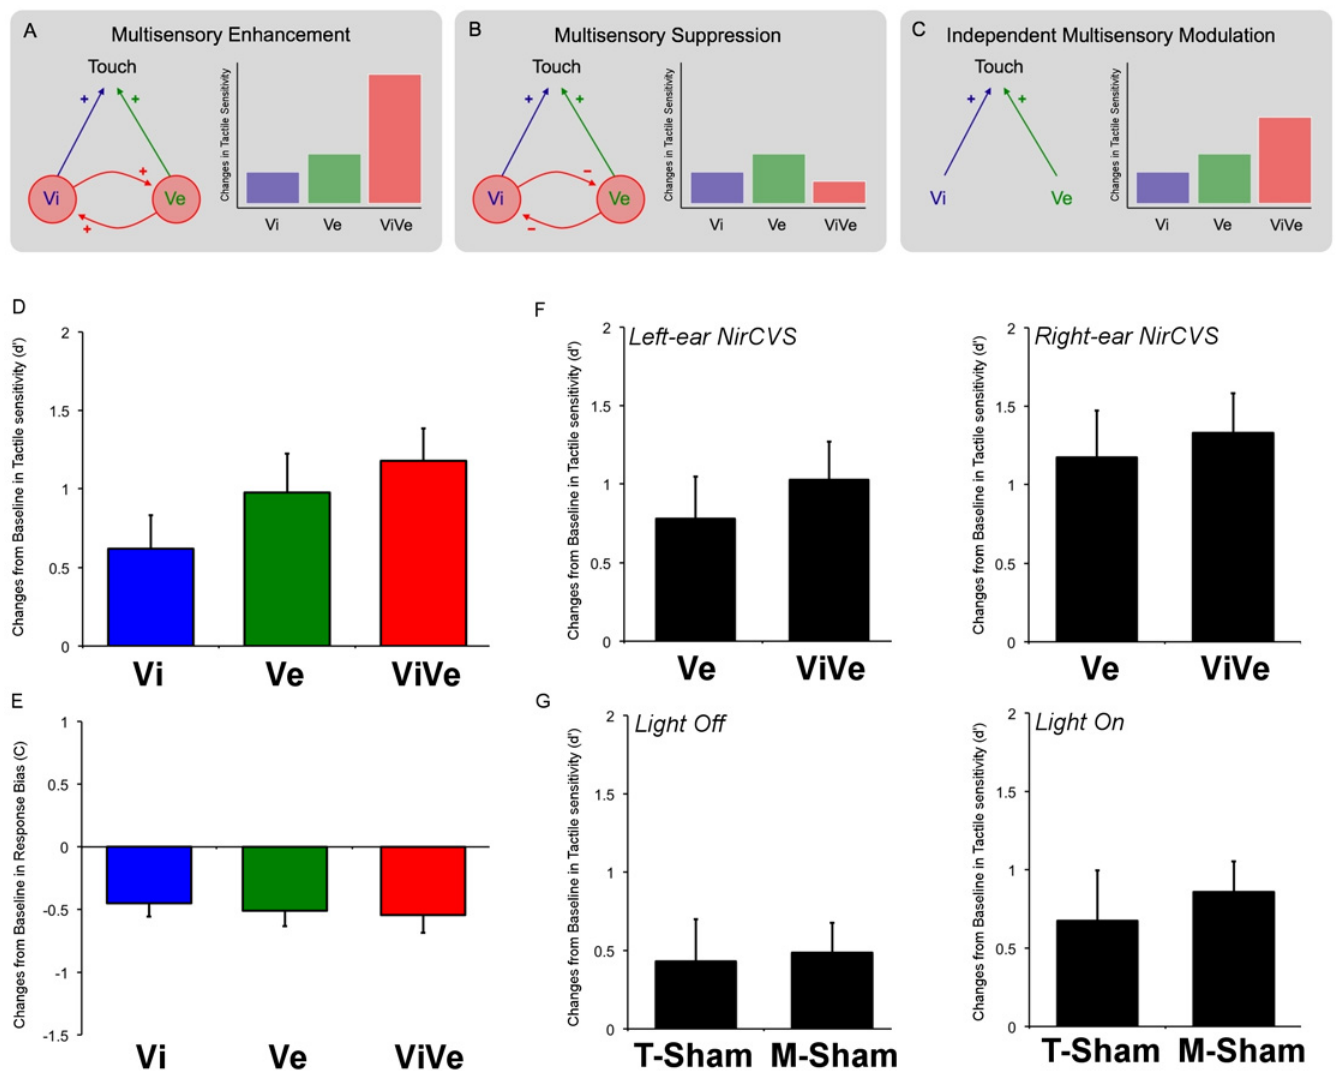
Fig 1. Models and experimental data. (A,B,C) Three schematic models for vestibular, visual and somatosensory interaction, and their possible implications for perceptual sensitivity. Ve: Vestibular condition, Vi: Visual condition, ViVe: combined Visuo-Vestibular condition. Based on previous neuroanatomical, neurophysiological and perceptual results, we focus on three types of multisensory interaction. (A) The three sensory events might produce superadditive multisensory enhancement of somatosensory sensitivity: an illustrative superadditive response is shown by the red bar. (B) Visual and vestibular signals interact through inhibitory connections, as previously described. This model predicts less than additive effects on somatosensory sensitivity: an illustrative example is shown by the red bar. (C) Visual and vestibular inputs might directly, but independently, influence somatosensory sensitivity through separate cross-modal connections leading to simple additive effects (red bar). (D) Changes from Baseline in somatosensory sensitivity in Visual condition, Vestibular condition and in the combined Visuo-Vestibular condition. Mean and standard errors of the mean are reported as function of the experimental condition. Data are presented collapsed across left ear and right ear stimulations. Positive values represent enhanced sensitivity. (E) Changes from Baseline in response bias in Visual condition, Vestibular condition and in the combined Visuo-Vestibular condition. Mean and standard error of the mean are reported as function of the experimental condition. Data are presented collapsed across left ear and right ear stimulations. Negative values in response bias represent a less conservative bias. (F) Changes from Baseline in somatosensory sensitivity in left ear and right ear stimulation in Vestibular condition and in Visuo-Vestibular condition. Mean and standard errors of the mean are reported as function of the experimental condition. (G) Changes from Baseline in somatosensory sensitivity in Thermal Sham (T-Sham) stimulation and Mechanical Sham (M-Sham) stimulation in light off and light on condition. Mean and standard errors of the mean are reported as function of the experimental condition. Data are presented collapsed across left and right ear stimulations.